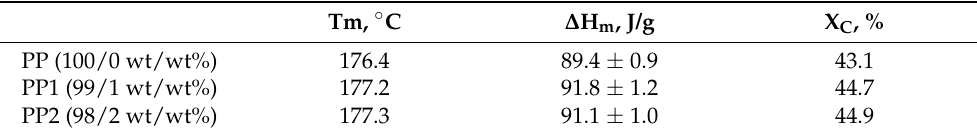
Table 1. Melting temperature, enthalpy of fusion and crystallinity of polypropylene and polypropy- lene nanocomposites.